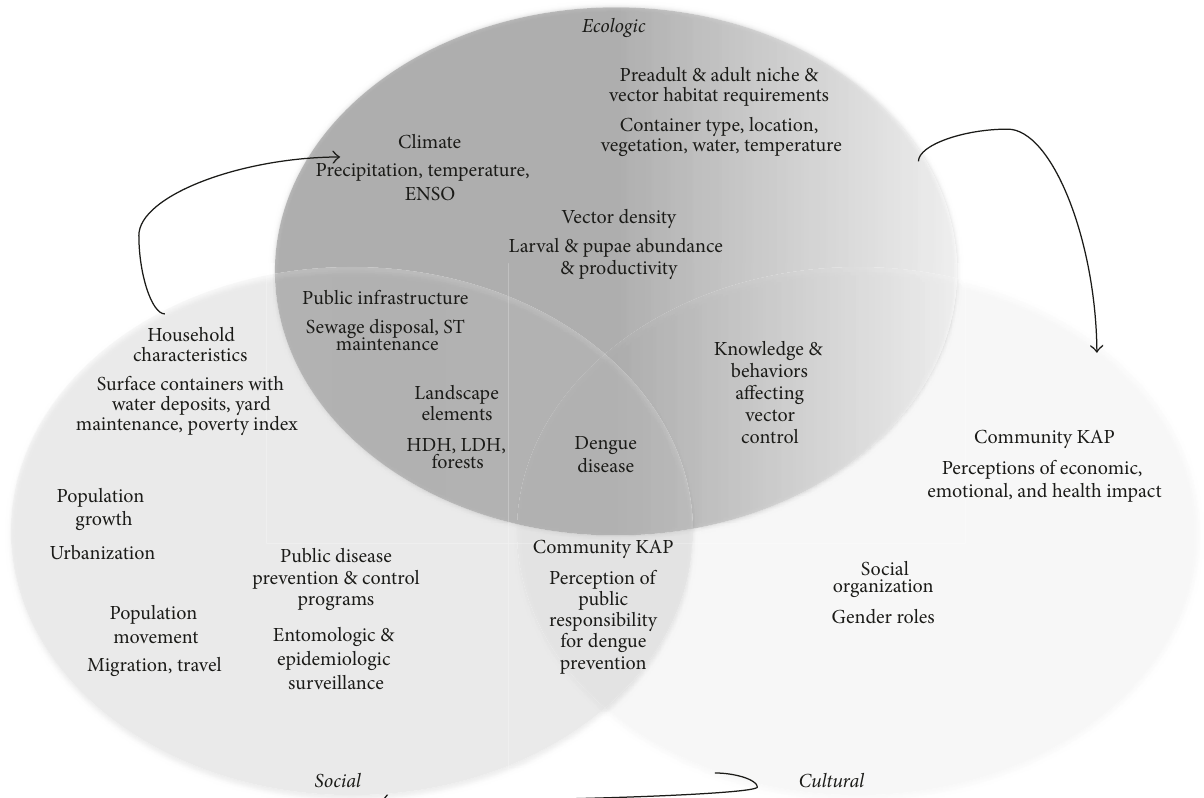
Figure 3: Study framework and results summarizing interrelationships between climatic, ecological, social, and cultural determinants affecting dengue emergence and transmission in Puerto